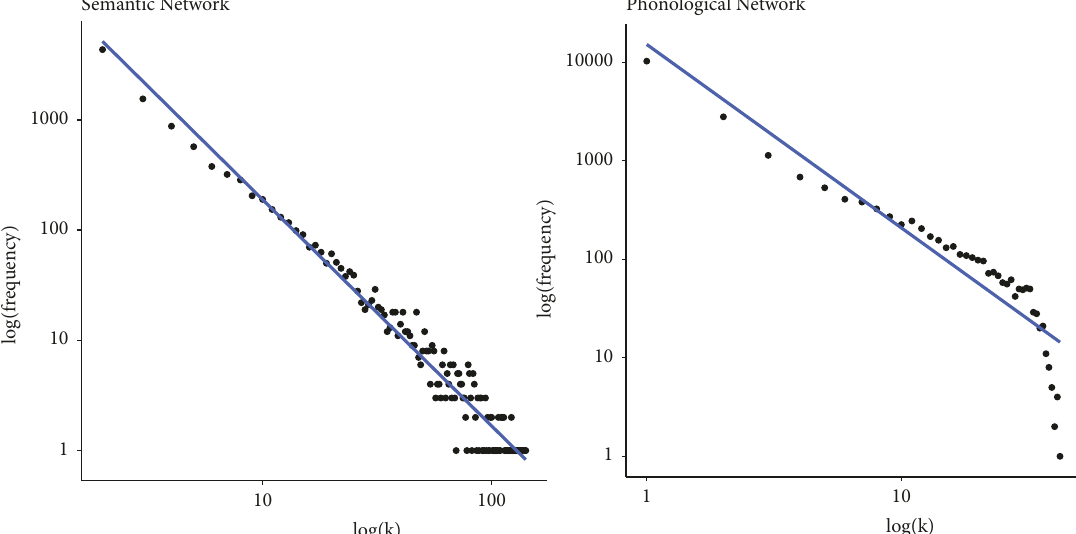
Figure 3: Degree distributions of semanticnetwork constructedfrom Nelsonet al.’s [31] free associationnorms and the phonological network from Vitevitch